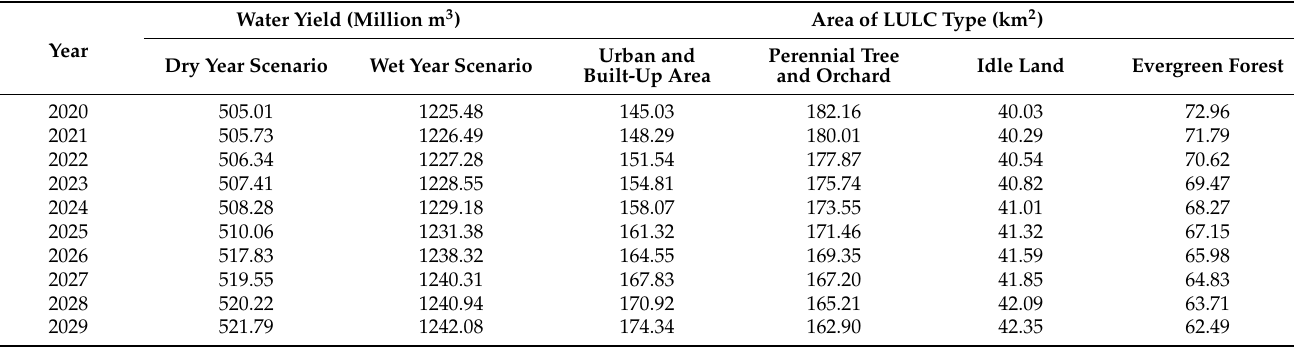
Table A3. Annual water yield (dependent variable) and primary LULC types (independent variable) area in Phuket Island between 2020 and 2029.